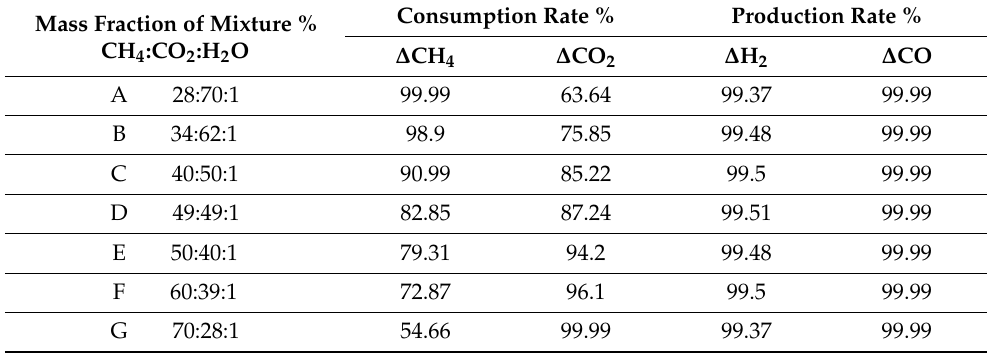
Table 6. Biogas conversion rate depending on feed composition (inert gas used to complete mixture). Mass Fraction of Mixture